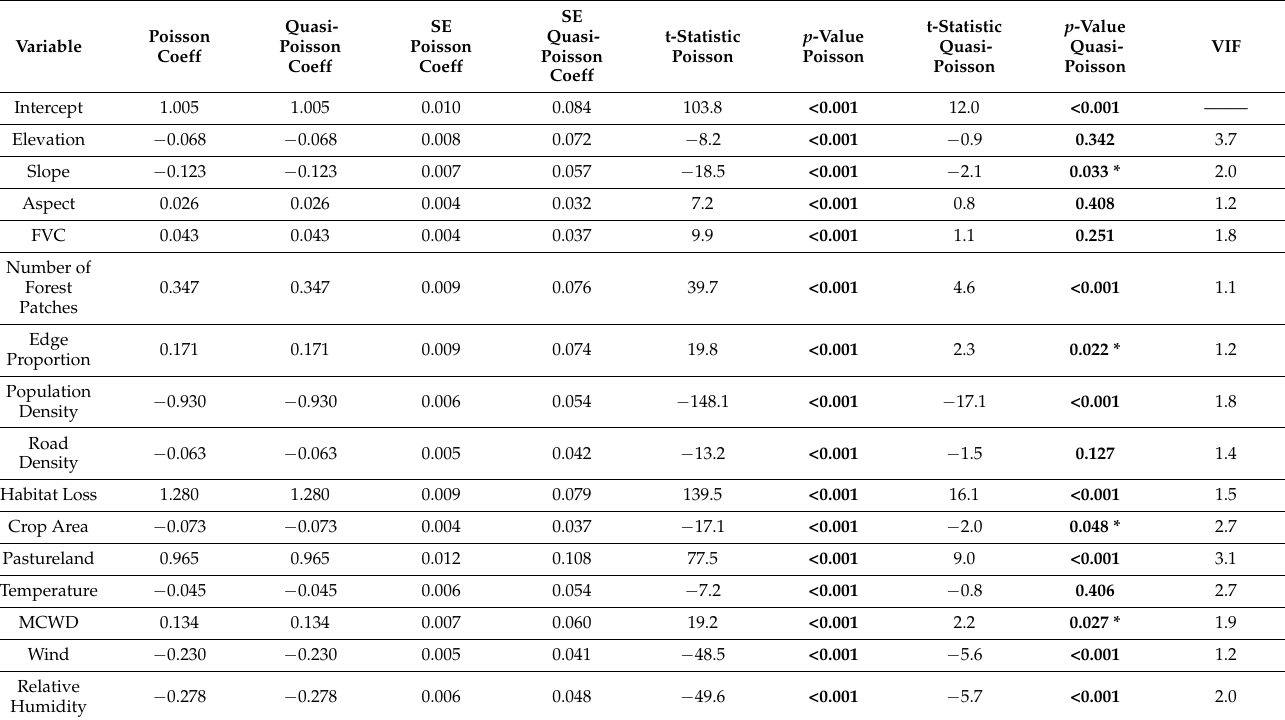
Table 3. Poisson and quasi-Poisson diagnostics